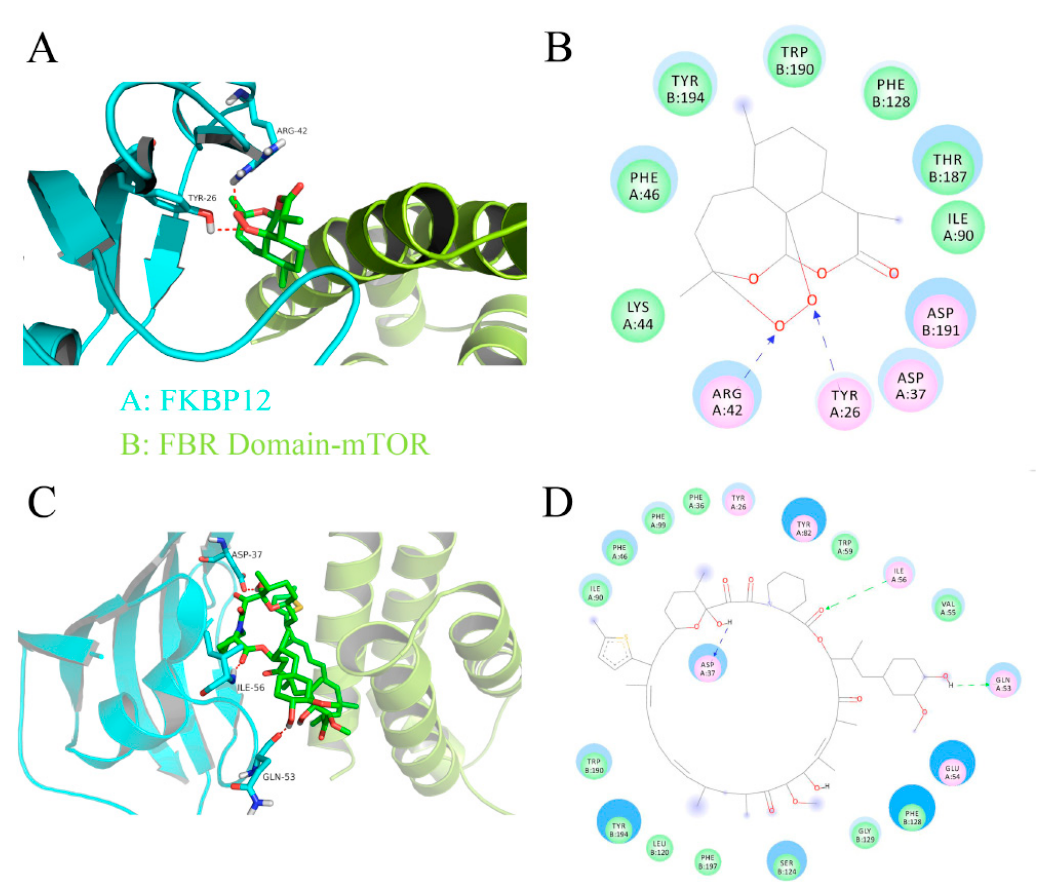
Figure 4. Predicted binding modes of dihydroartemisinin ( A , B ) and rapamycin ( C , D ) in the interface cavity of FKBP12 and the FRB domain of mTOR. The 3-D structure of the protein complex of FKBP12 and the FRB domain was taken from the PDB database (PDB ID: 3FAP). The calculated binding mode of DHA in the interface cavity of FKBP12 and the FRB domain of